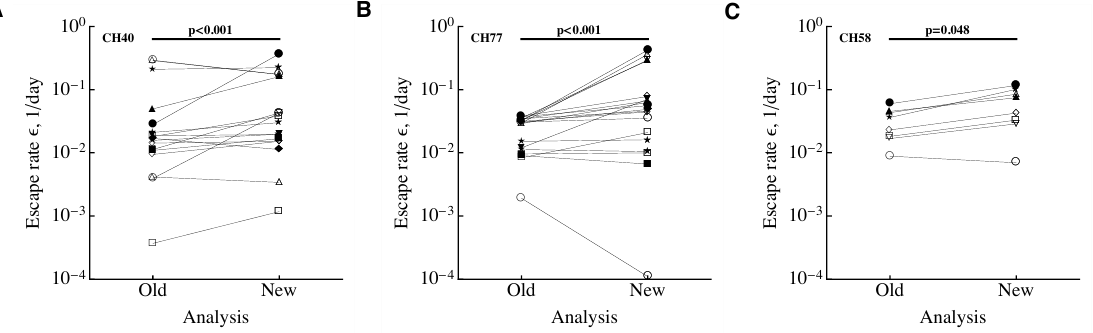
Figure 3. A sampling method provides higher estimates of the escape rates. We plot estimates of HIV escape rates in three patients (panel A : CH40, panel B : CH77, panel C : CH58) as was found a previous study [25] employing data modifications (“Old” analysis) and estimates found using sampling method (“New” analysis). Different markers on plots indicate escape rate estimates for different escapes in our previous analysis [25]. Comparison of the escape rates in two analyses was done using Wilcoxon signed rank test and p values from these tests are indicated on individual